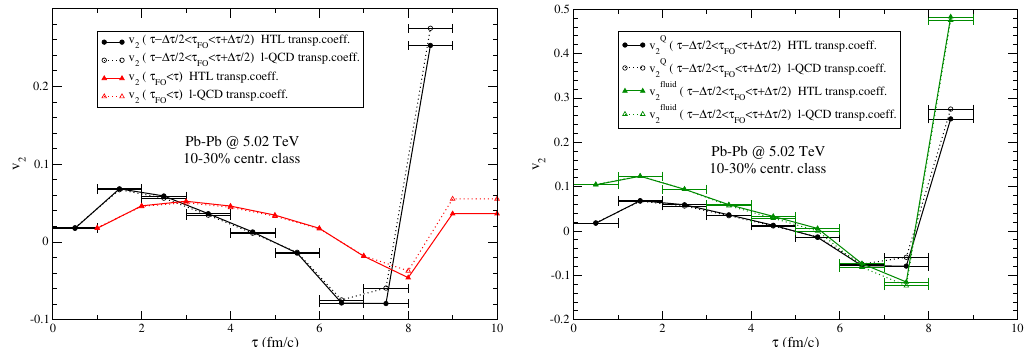
Figure 4 . The elliptic (cid:13)ow of charm quarks decoupling at various values of the longitudinal proper- time (cid:28) in 10{30% Pb-Pb collisions. The (cid:12)nal integrated result (red curves with triangles in the left panel) comes from the interplay of opposite-sign contributions from the initial, intermediate and (cid:12)nal stages of the (cid:12)reball evolution. Di(cid:11)erences between results obtained with weak-coupling and l-QCD transport coe(cid:14)cients look mild. In the right panel the heavy-quark v 2 is compared to the one of the (cid:13)uid cells from which they decouple.